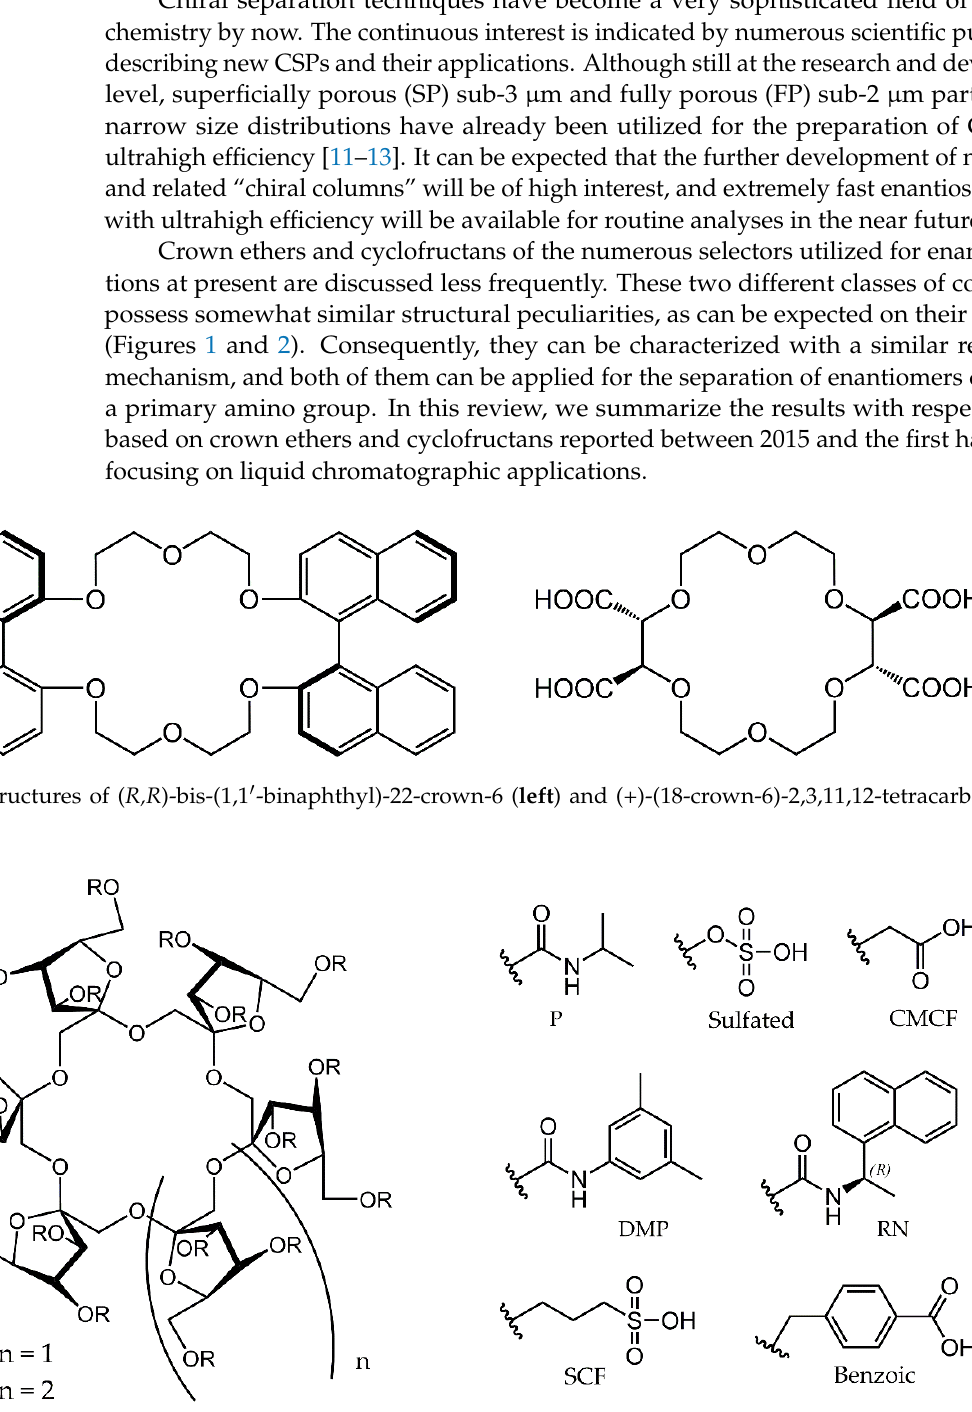
Figure 2. The general structure of cyclofructans (left) and their derivatives (right).